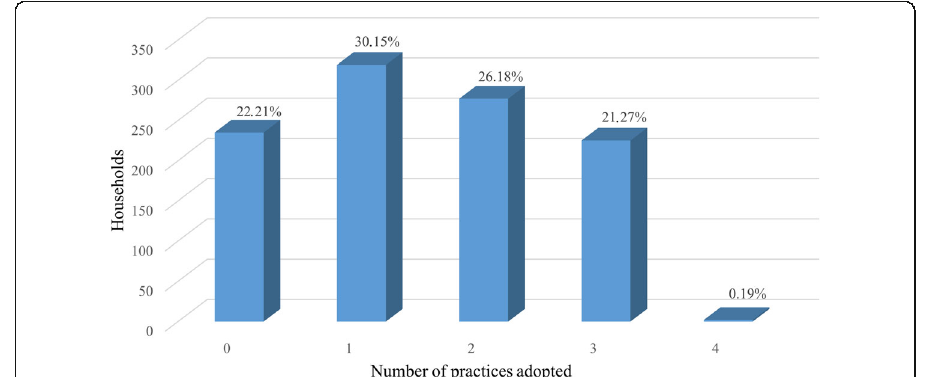
Fig. 3 Level of adoption of the integrated BXW control